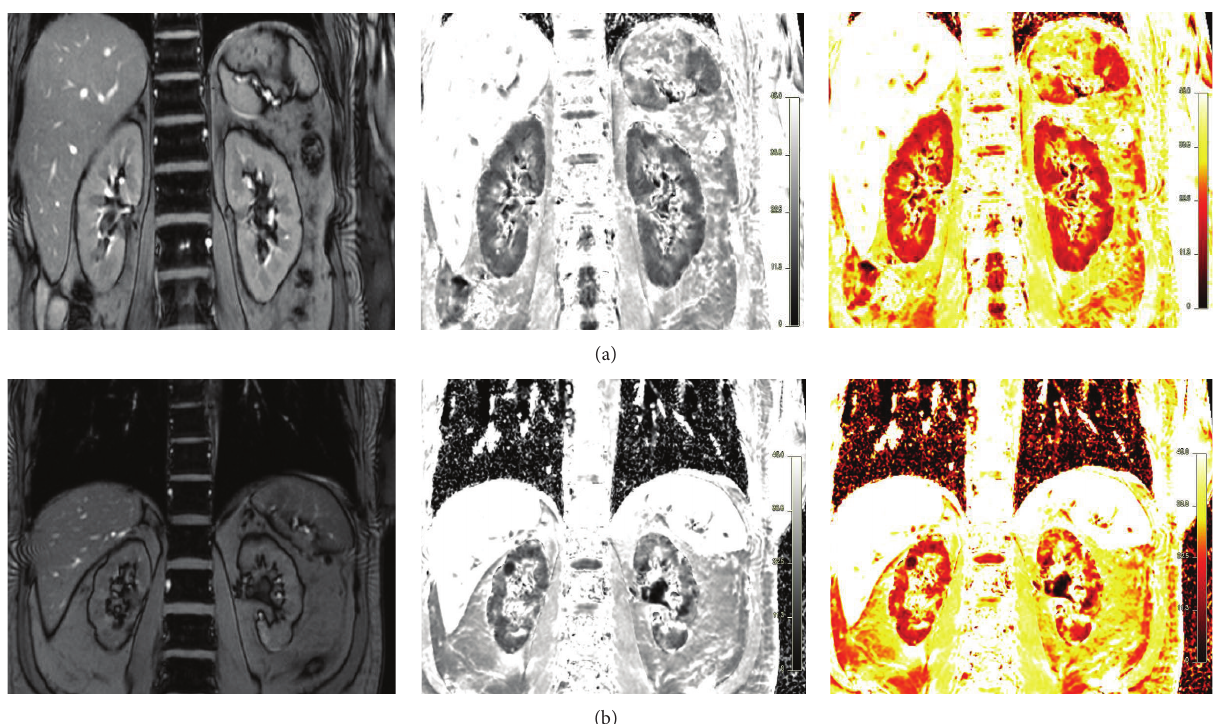
Figure 1: Example of blood oxygenation level-dependent MRI (BOLD-MRI) in a healthy volunteer (a) and in a patient suffering from chronic kidney disease (b). The anatomical templates are shown on the left side, the R 2 ∗ maps in the middle, and the corresponding color maps on the right; low R 2 ∗ levels (and supposed higher tissue oxygenation) in red and high R 2 ∗ levels in